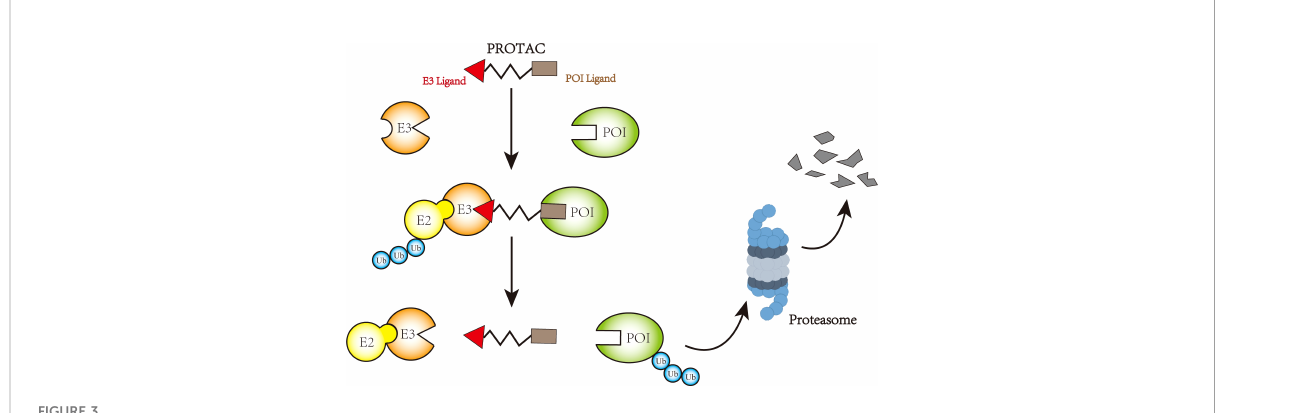
FIGURE 3 Mechanism of PROTAC-mediated protein